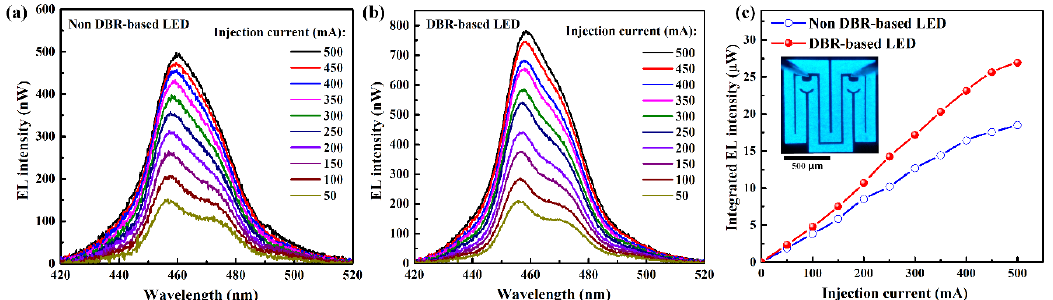
Figure 6. Electroluminescence (EL) spectrum of ( a ) the non-DBR-based and ( b ) the DBR-based LEDs at different injection currents. ( c ) Integrated EL intensity (light output) of the DBR-based and the non-DBR-based LEDs, with an insert of a DBR-based LED chip with the size of 1 mm × 1 mm.